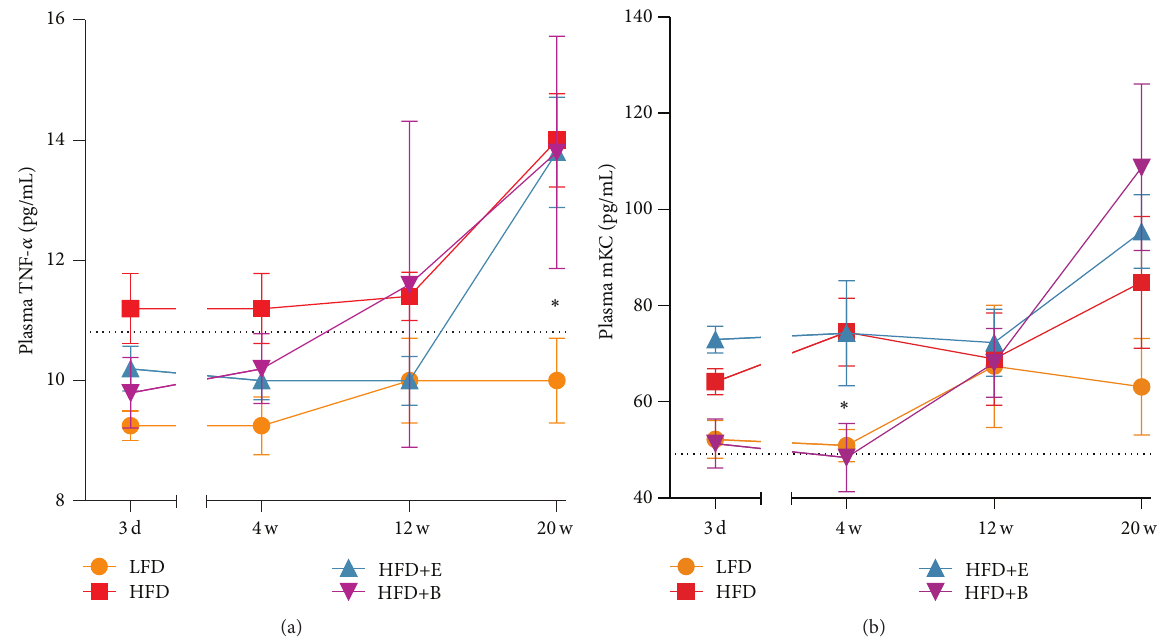
Figure 4: Systemic proinflammatory mediators. (a) Polyphenols do not prevent the HFD-induced increase in levels of TNF- 𝛼 as measured in serial plasma samples ( 10.50 ± 0.29 at baseline). (b) Plasma levels of the neutrophil chemoattractant mKC are suppressed in the HFD+B group until 4 w but increase thereafter ( 49.00 ± 3.63 at baseline). Dotted lines depict baseline values. Significant from HFD ( ∗ 𝑝 < 0.05